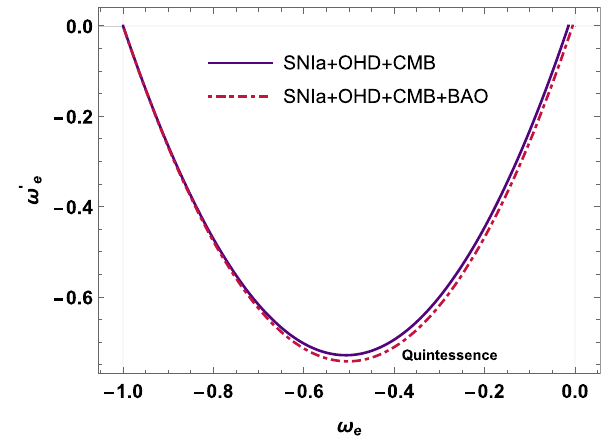
Fig. 7 TheevolutionarytrajectoryforinteractingTHDEinthe ω (cid:2) e − ω e plane for the best estimated values of the model parameters using the fourth and sixth